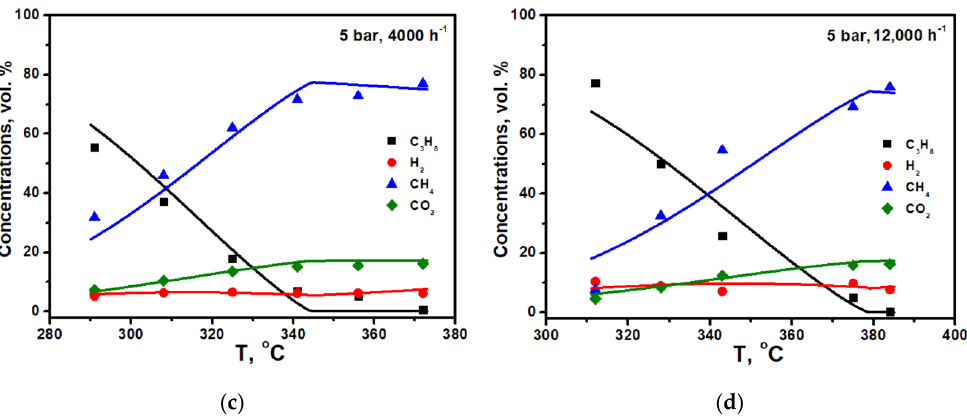
Figure 2. Temperature dependences of the outlet concentrations of propane, methane, CO 2 and hydrogen in propane pre-reforming. Points are the experiment, and lines are the modeling. Experimental conditions: 25 vol.% C 3 H 8 , 75% H 2 O and pressure 1 bar. The solution of the inverse problem is power law dependence with a propane effective reaction order of 0.15. Concentrations of the gas components on the figure are given on the dry basis. Figure 2a shows the results for the experiments under 1 bar and 4000 h −1 , Figure 2b—1 bar and 12,000 h −1 , Figure 2c—5 bar and 4000 h −1 , Figure 2d—5 bar and 12,000 h −1 .